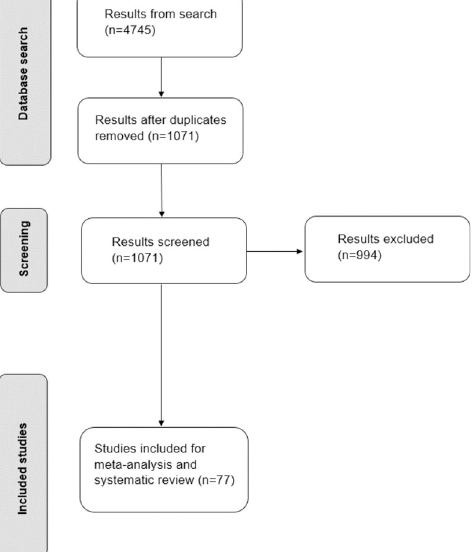
Fig 1. Flow chart of search strategy. Summary of search strategy and eligible study